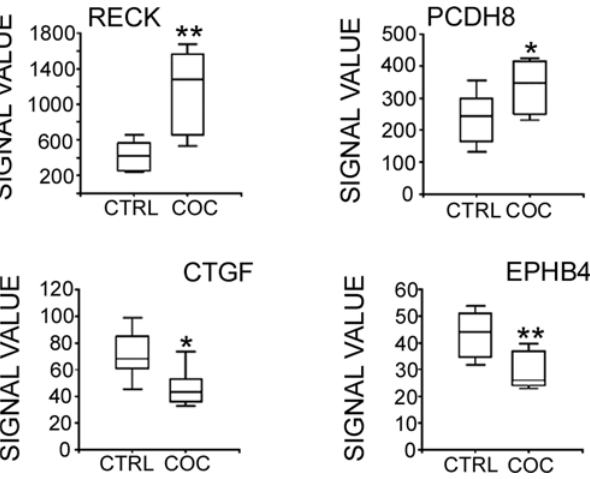
Figure 2. Graphic representation of the observed changes in RECK, PCDH8, CTGF, and EPHB4 gene expression. Raw Affymetrix data (Microarray Analysis Suite version 5.0) illustrate the differential expression of these genes in the hippocampus. Box plot illustrates range and median values. ** p # 0.001; * p # 0.01